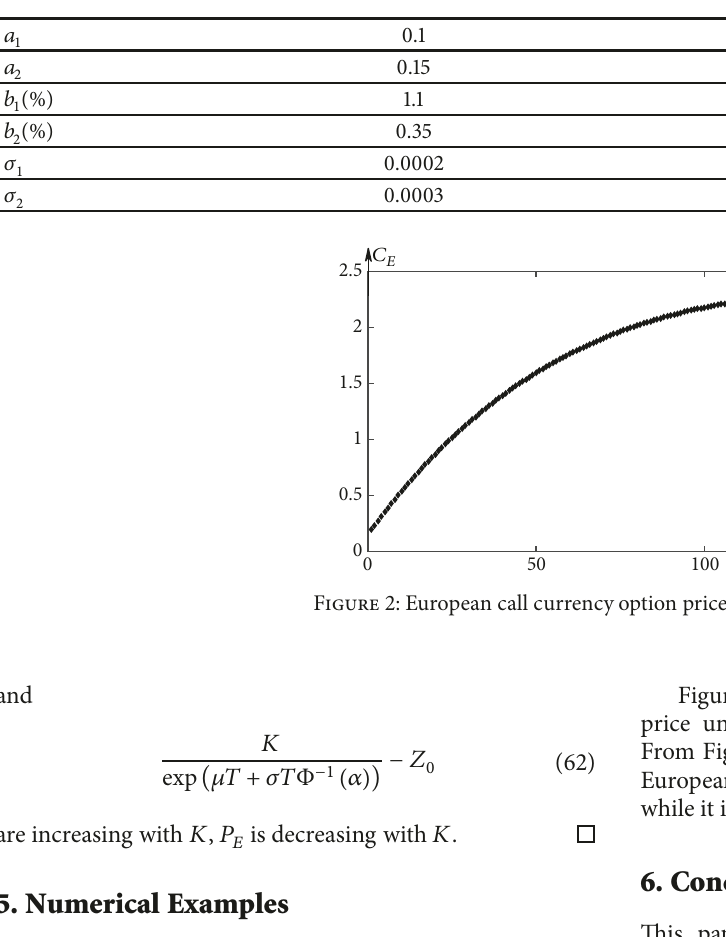
Table 2: Parameters setting in model (10).